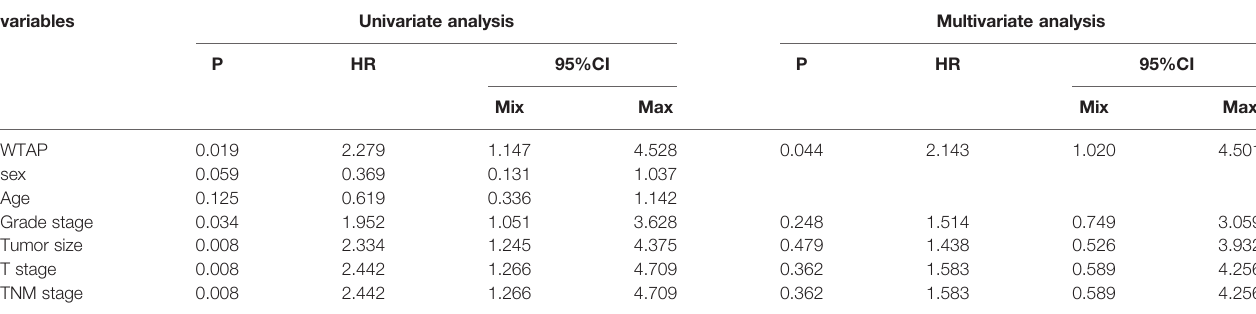
TABLE 4 | Univariate and multivariate analyses of WTAP expression in the nucleus associated with overall survival of liver cancer patients. variables Univariate analysis Multivariate